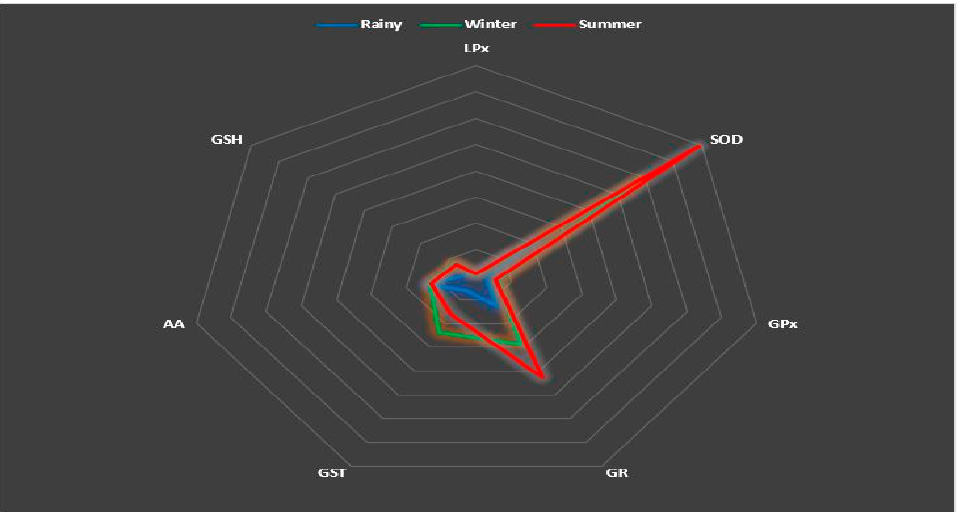
mined, which were divided into three groups among the rainy, winter and summer seasons.